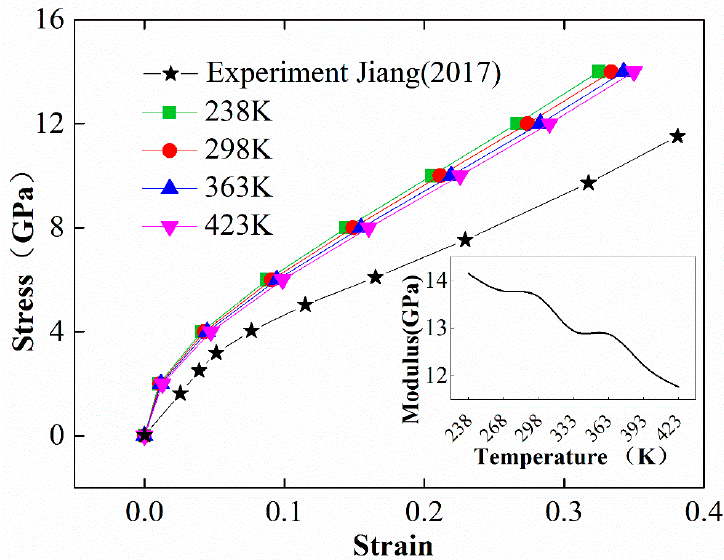
Figure 7. The colored curves are stress–strain curves of EPDM, the star curve is the uniaxial compression EPDM stress–strain curve measured by Jiang at 298 K, and the inset is the modulus (the ratio of stress to strain when the stress magnitude is equal to 14 GPa) at different temperatures.